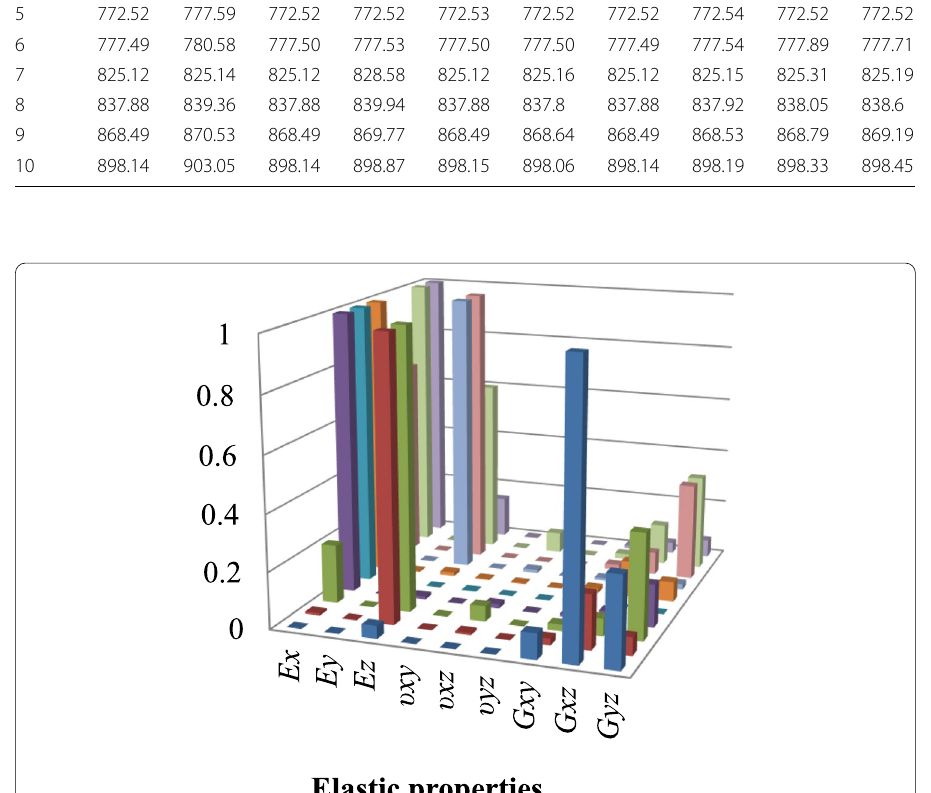
Fig. 10 Sensitivity analysis for